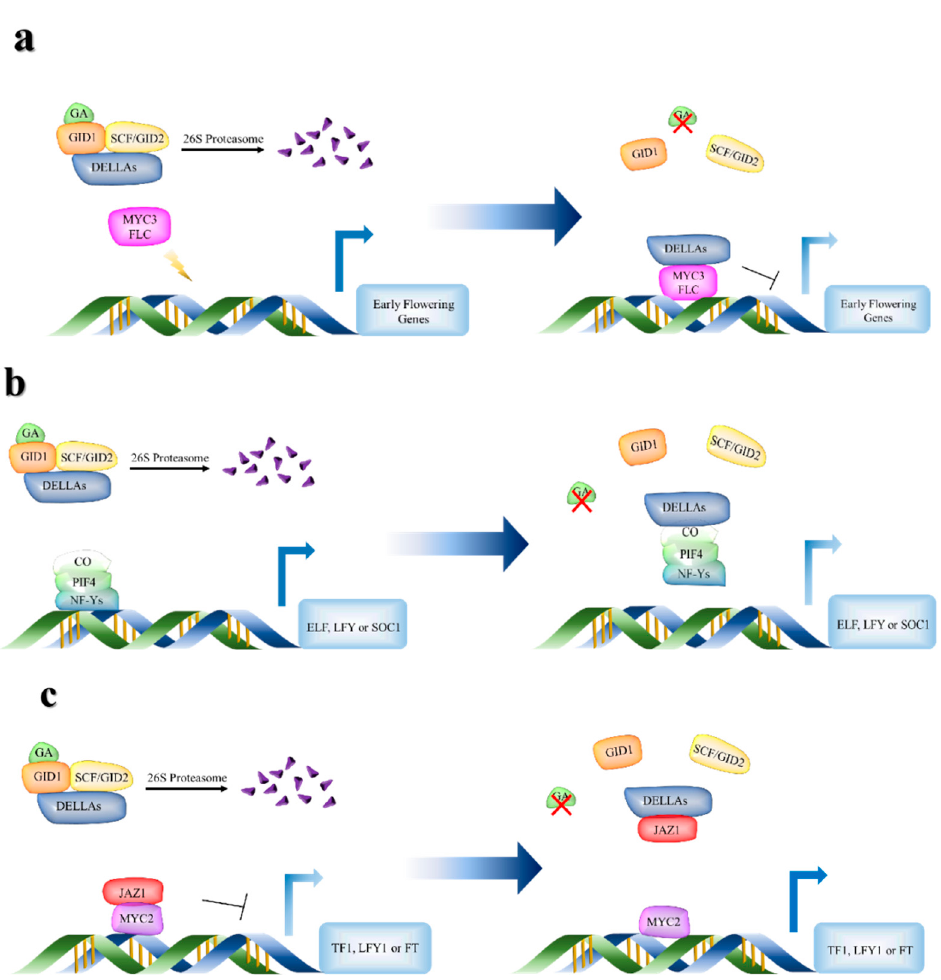
Figure 11. Phytohormone regulated expression model of floral development related genes in two different flower buds of chestnut in pre ‐ winter and post ‐ winter. ( a ) In pre ‐ winter, the higher GA content promoted the increase in GID1 and GID2 expression levels, and inhibited the expression of DELLAs gene, further decrease the transcription level of MYC3 and FLC , which was conducive to breaking dormancy and promoting the development of male inflorescence in the two different flower buds; ( b ) In post ‐ winter, the decrease in GAs content led to the decrease in GID1 and GID2 expression levels and the increase in DELLAs expression levels in IMF, which decrease the expression of FT / LFY / SOC1 and other genes, and thus inhibited the differentiation of female flower buds; ( c ) The content of JA ‐ ILE increases significantly and the GAs decreases in CMF in post ‐ winter, which lead to the transcription level of JAZ1 decreases and the expression level of DELLAs increases. The higher DELLAs protein binds to JAZ1 in CMF in post ‐ winter. This competitive binding enables the JAZ1 ‐ MYC2 complex to release MYC2, and the higher transcriptional level of MYC2 initiates the expression of genes related to female flower development, such as TF1 , LFY1 , and FT .